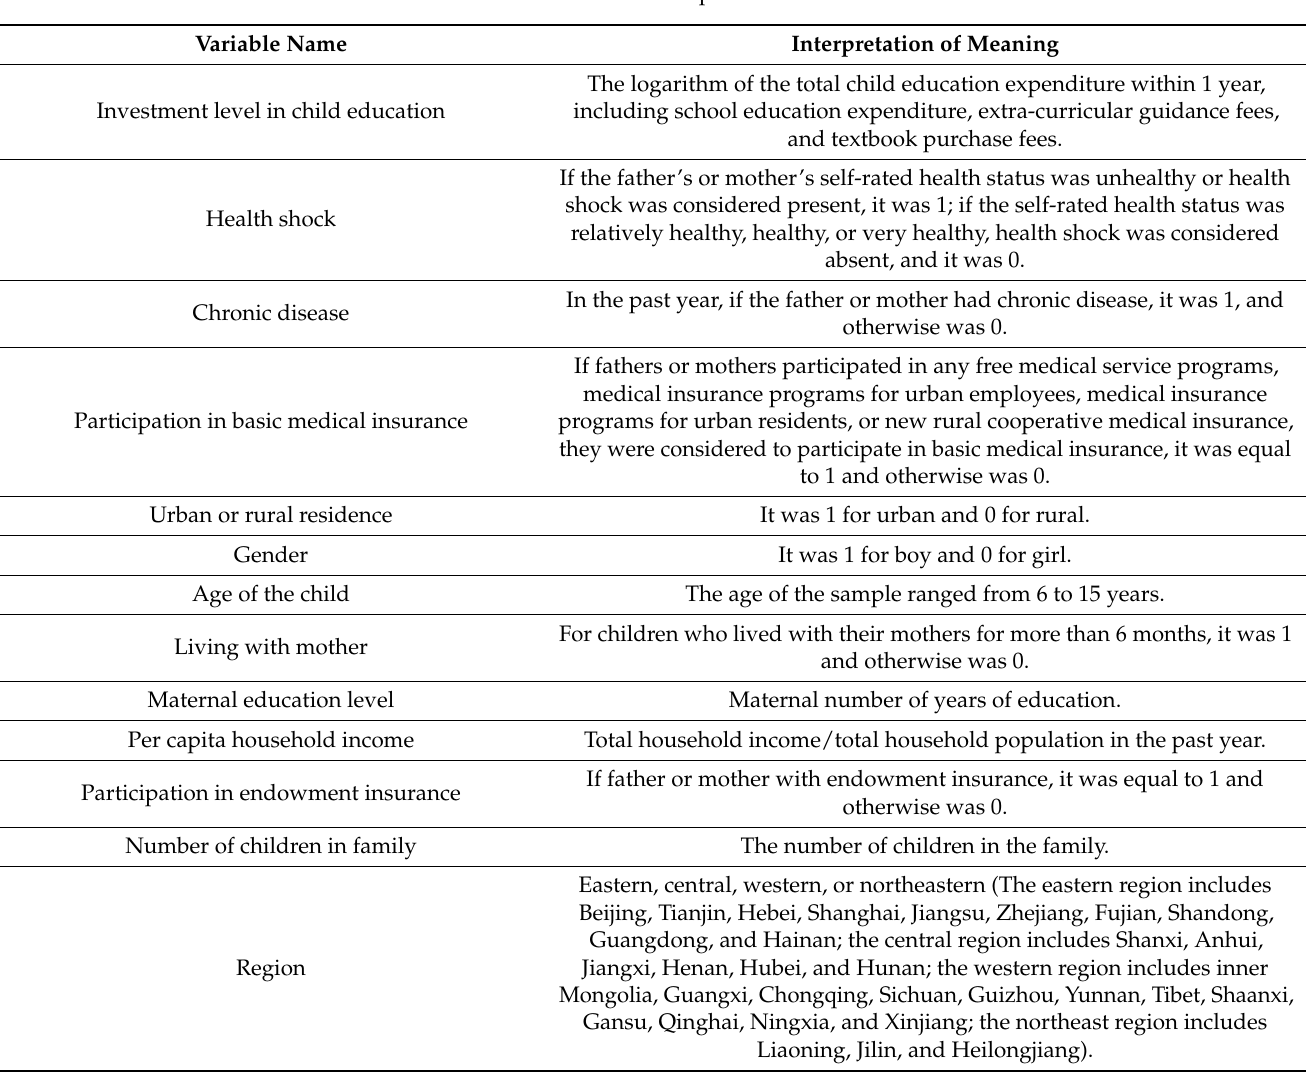
Table 1. Variable